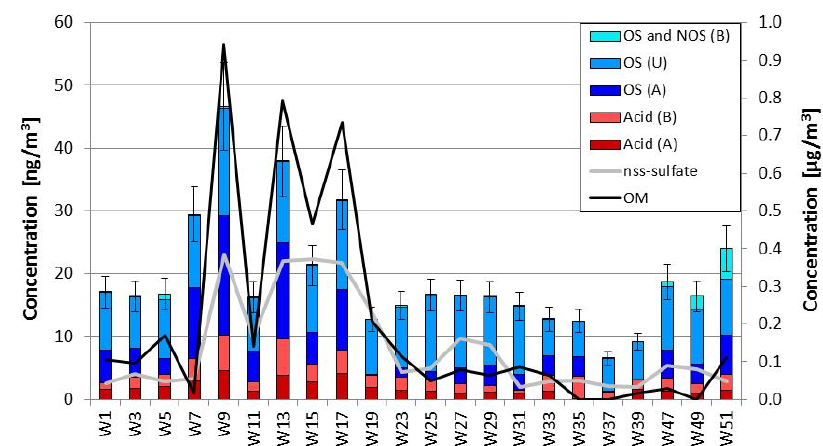
Figure 6. Variation in total air concentration (ngm − 3 ) of observed acids and organosulfates from anthropogenic (A), biogenic (B) and unknown (U) precursors during a full annual cycle at Zeppelin Mountain, Svalbard, 2008. Approximately two samples are collected for each month, W1 and W3 from January; W5, W7 and W9 from February; W11 and W13 from March; W15 and W17 from April; W19 from May; W23 and W25 from June; W27 and W29 from July; W31, W33 and W35 from August; W37 and W39 from September; W47 from November; and W49 and W51 from December. nss-sulfate and OM (µgm − 3 ) are depicted on the secondary axis. The error bars show the estimated 15% uncertainties on the